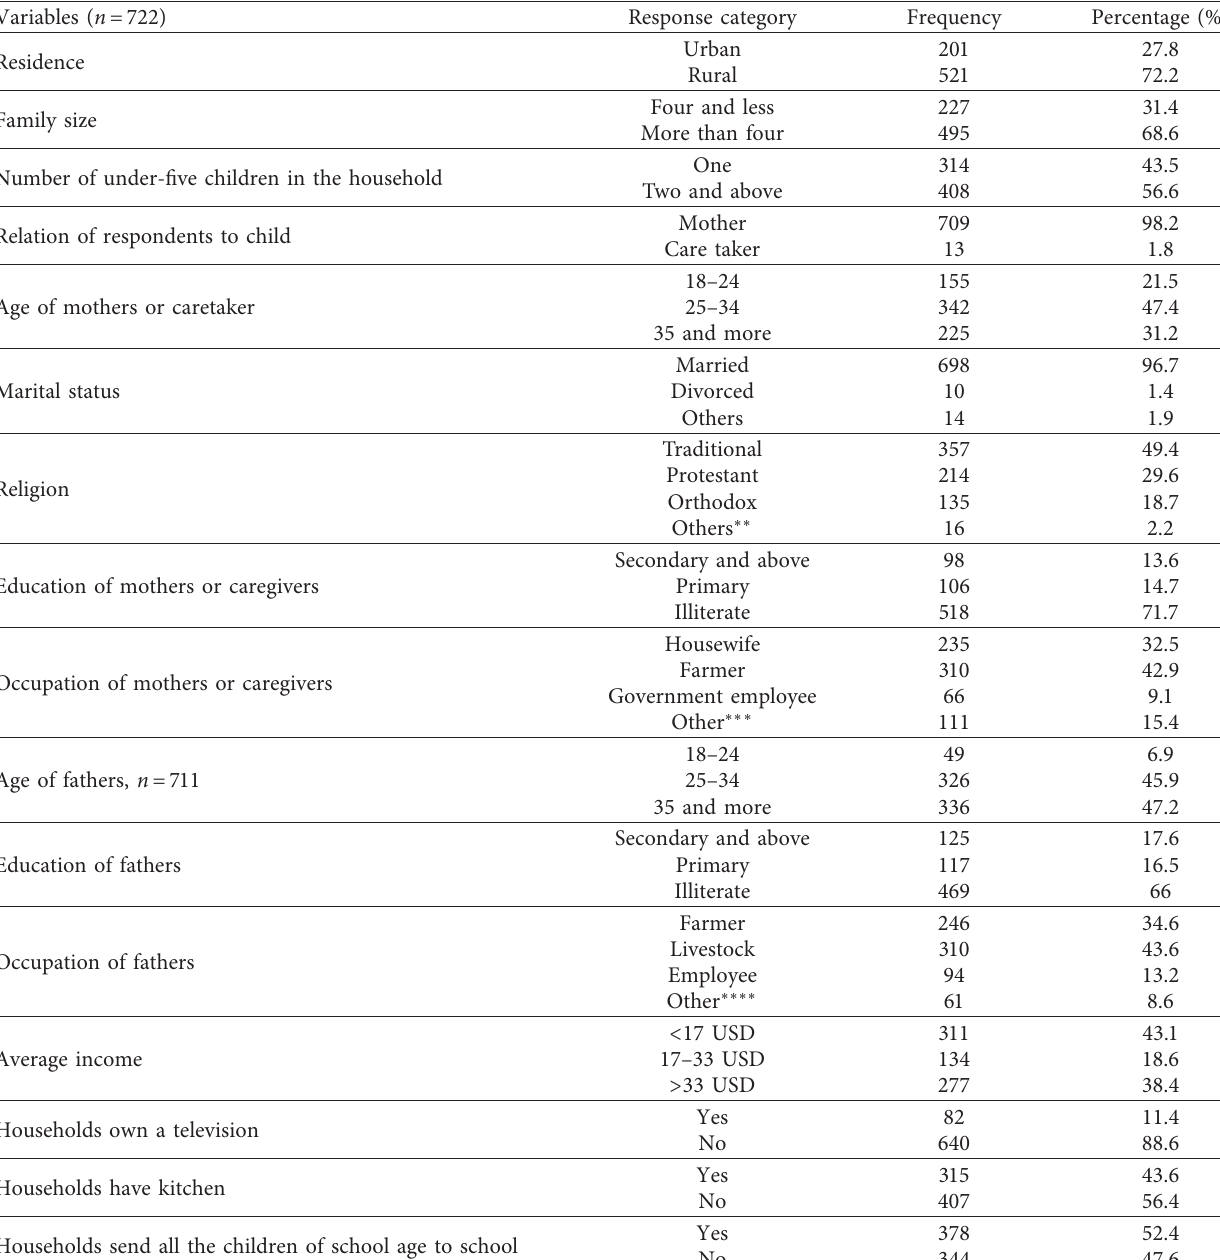
Table 1: Demographic and socioeconomic characteristics of the households in Benna Tsemay District, South Omo Zone, Southern Ethiopia, 01 January to 30 February,